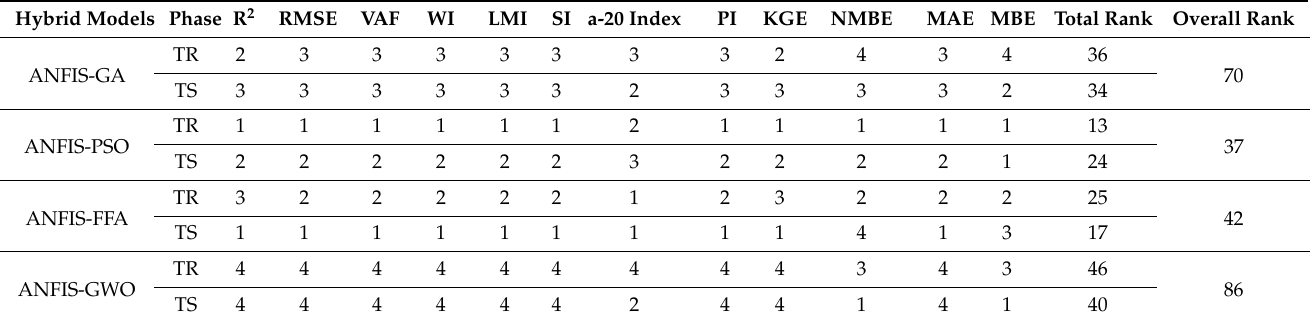
Table 4. Rank analysis of hybrid ANFIS model (training and testing